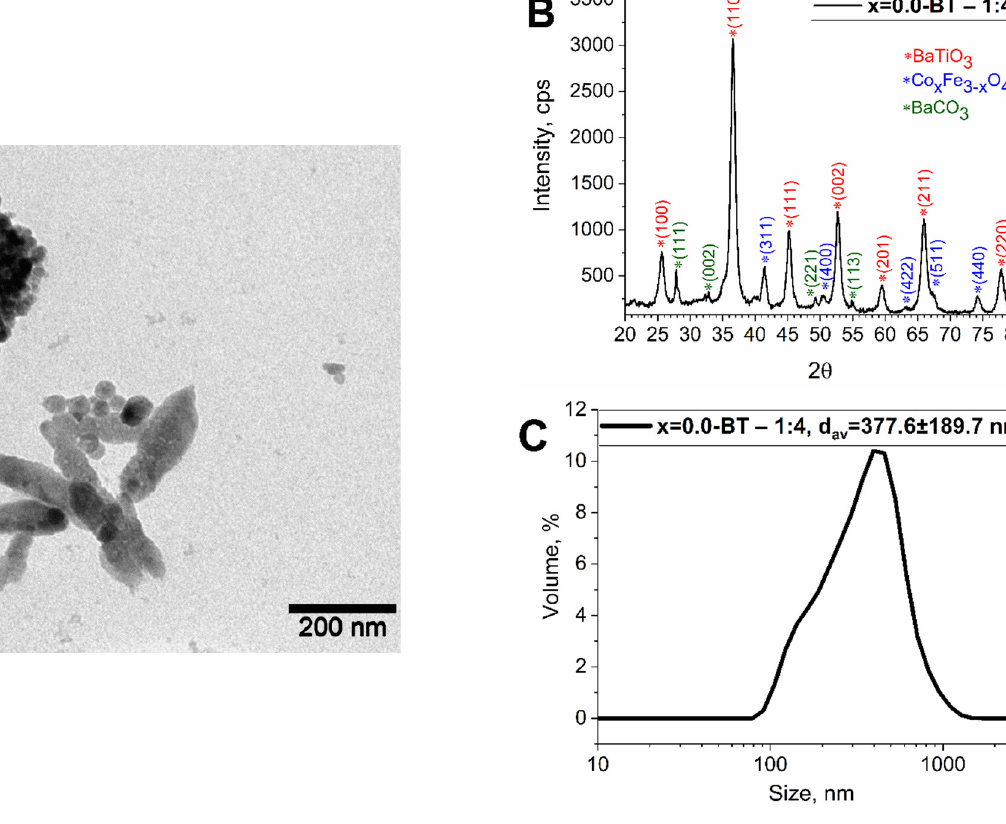
Figure 6. TEM ( A ), XRD ( B ), and DLS ( C ) data for sample x = 0.0-BT—1:4.